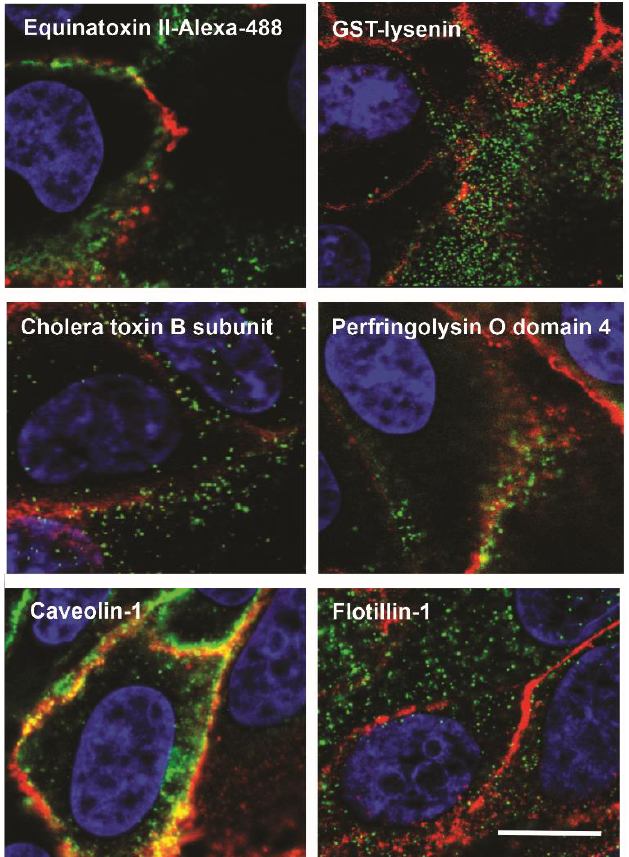
Figure 2. Distribution of OlyA–mCherry and established lipid raft markers. Representative fluo- rescent images of double immunolabeling of fixed MDCK cells treated simultaneously for 10 min with OlyA–mCherry (1 μM; red) and toxin-derived probes (green) that detect sphingomyelin (ly- senin, equinatoxin II), cholesterol (domain 4 of perfringolysin O), ganglioside GM1 (cholera toxin, subunit B), or intrinsic proposed membrane markers (caveolin-1, flotillin-1). Blue, DAPI (diamidino- 2-phenylindole). Scale bar: 20 µm.